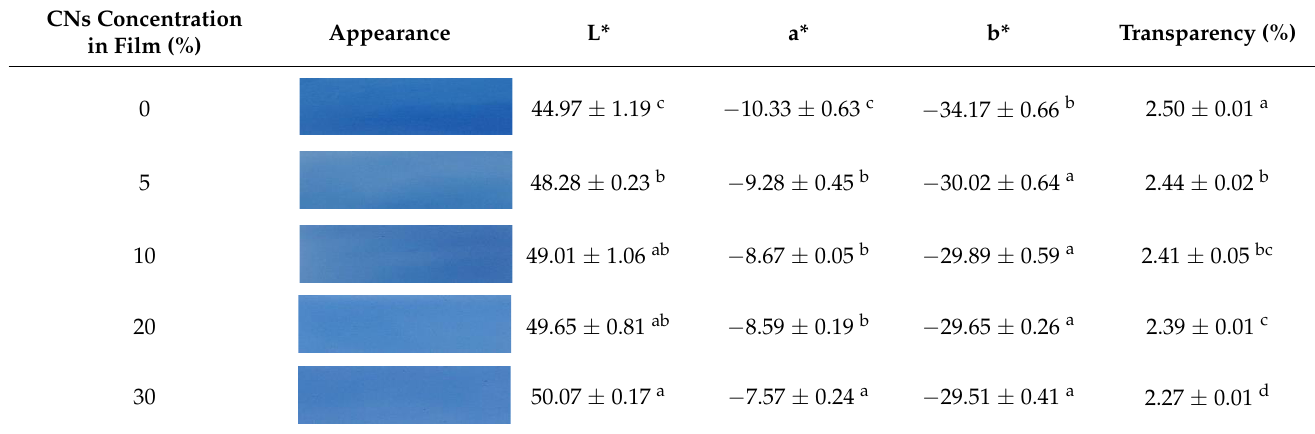
Values are given as mean ± SD, n = 3. Different superscripts in each column are significantly different ( p < 0.05). Table 2. Appearance, color, and transparency of smart bilayer film incorporated with different Table 2. Appearance, color, and transparency of smart bilayer film incorporated with different Table 2. Appearance, color, and transparency of smart bilayer film incorporated with different Table 2. Appearance, color, and transparency of smart bilayer film incorporated with different Table 2. Appearance, color, and transparency of smart bilayer film incorporated with different Table 2. Appearance, color, and transparency of smart bilayer film incorporated with different concentrations of cellulose nanosphere (CNs). concentrations of cellulose nanosphere (CNs). concentrations of cellulose nanosphere (CNs). concentrations of cellulose nanosphere (CNs). concentrations of cellulose nanosphere (CNs). concentrations of cellulose nanosphere (CNs).